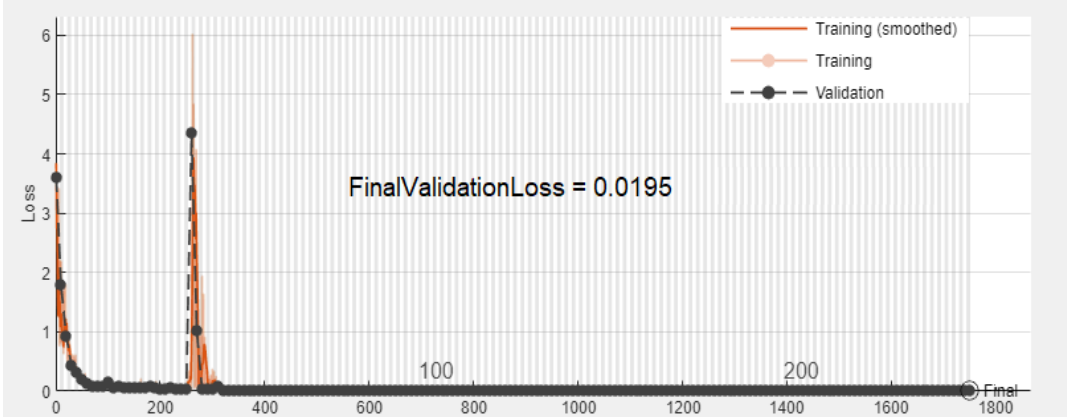
Figure 9. Experiment 1: Validation error convergence progress for two classes: Normal and Abnormal using